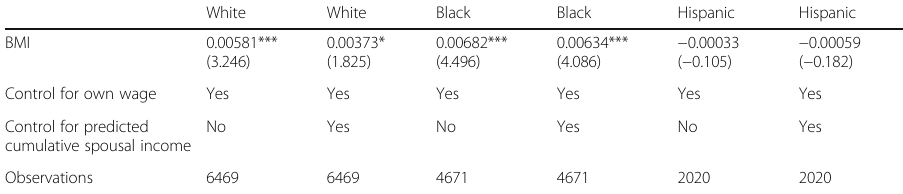
Table 6 BMI and log hours of work for single women: with and without predicted cumulative spousal income White White Black Black Hispanic Hispanic BMI